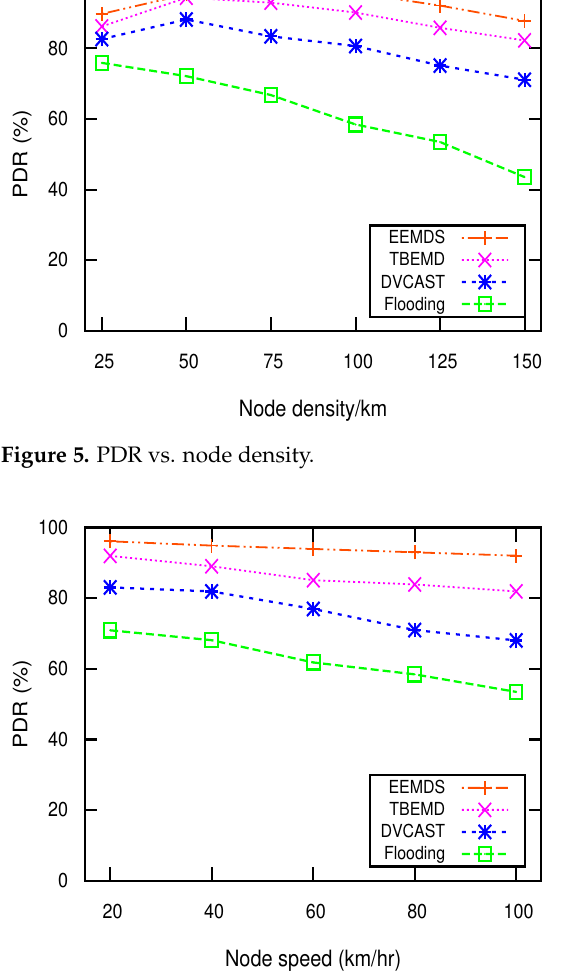
Figure 6. PDR vs. node